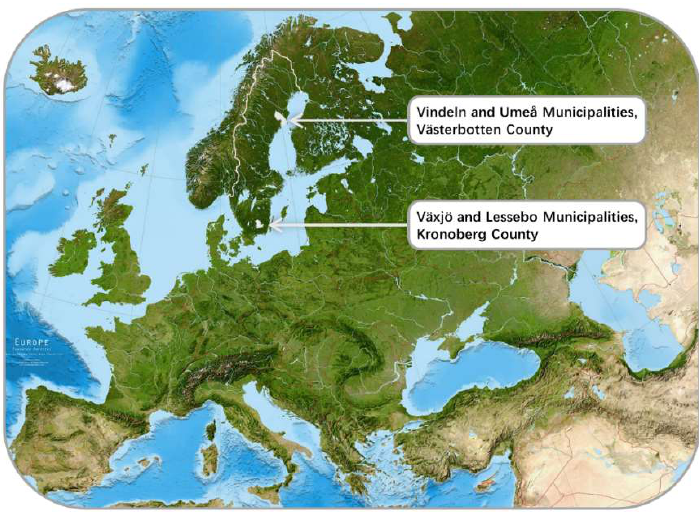
Figure 2. The location of the study areas in northern and southern Sweden. Satellite image from Wikimedia Commons, created by Koyos with NASA WorldWind; and geographical distribution of our study areas visualized with data from Lantmäteriet.